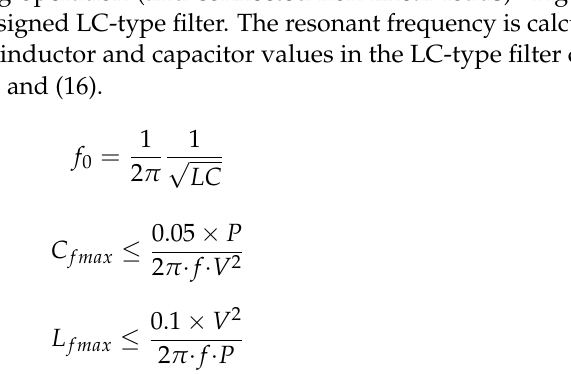
Figure 15 . A map representation of the distribution network of the modelled mini-grid.